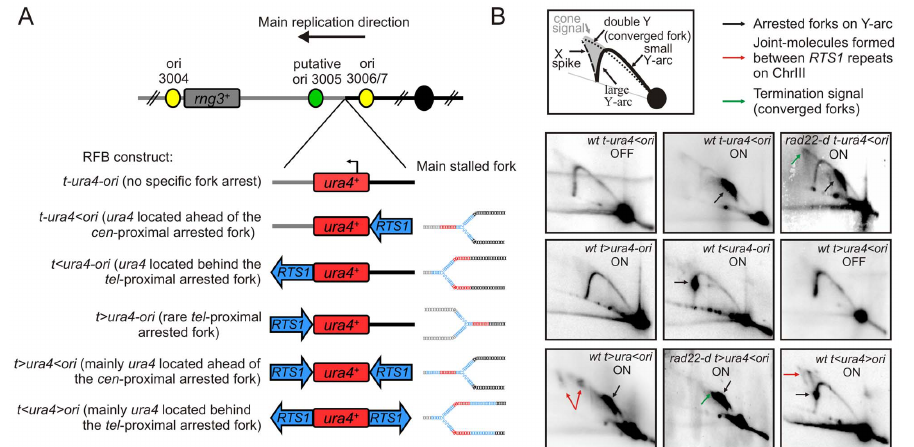
Figure 1. Conditional replication fork-arrest assays. A. Diagrams of fork-arrest constructs. Centromere -proximal and telomere -proximal regions are represented in black and grey, respectively. Strong or putative replication origins (ori) and the centromere are indicated by yellow, green and black circles, respectively. Blues arrows indicate the polarity of the RTS1 -RFB. The ura4 + gene is indicated in red and the arrow indicates its direction of transcription. Representations of the primary arrested fork structure are given for each construct. The name of each fork-arrest construct is given using the following nomenclature: ‘‘t’’ and ‘‘ori’’ refer to the telomere and the replication origin 3006/7, respectively; ‘‘ , ‘‘ and ’’ . ’’ indicate the RTS1 - barrier and its polarity ( , blocks replication forks moving from the ori3006/7 towards the telomere, and . blocks replication forks moving from the telomere towards the origin 3006/7. B. Diagrams of replication intermediates (RIs) within the A se I fragment analysed by 2DGE (top panel). Representative RIs analysed by 2DGE in indicated strains in OFF (Rtf1 being repressed) and ON (Rtf1 being expressed) conditions. Signal corresponding to arrested forks, joints-molecules (JMs) and termination structures are indicated by black, red and green arrows, respectively. Note that the t . ura4-ori construct does not result in a strong fork arrest as the RTS1 -RFB is not orientated in the main direction of replication (see text for details).